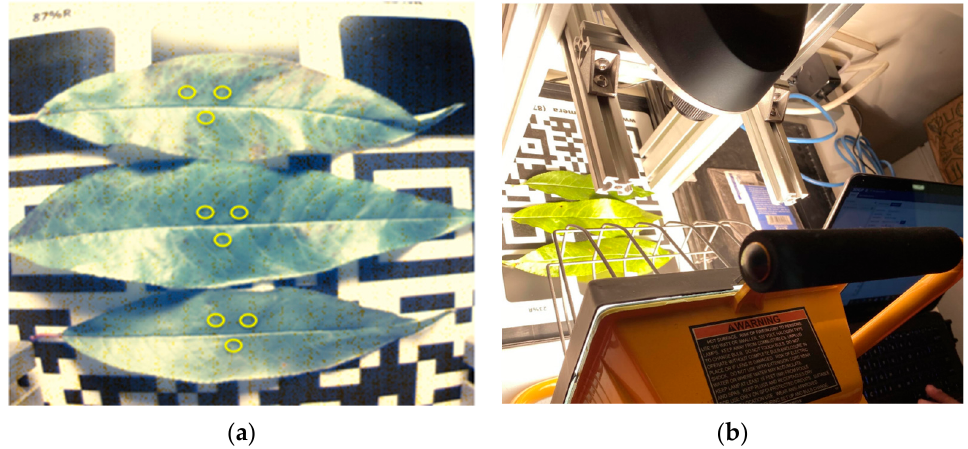
Figure 2. ( a ) Three points sampling for each leaf, and ( b ) the setup for the hyperspectral imaging